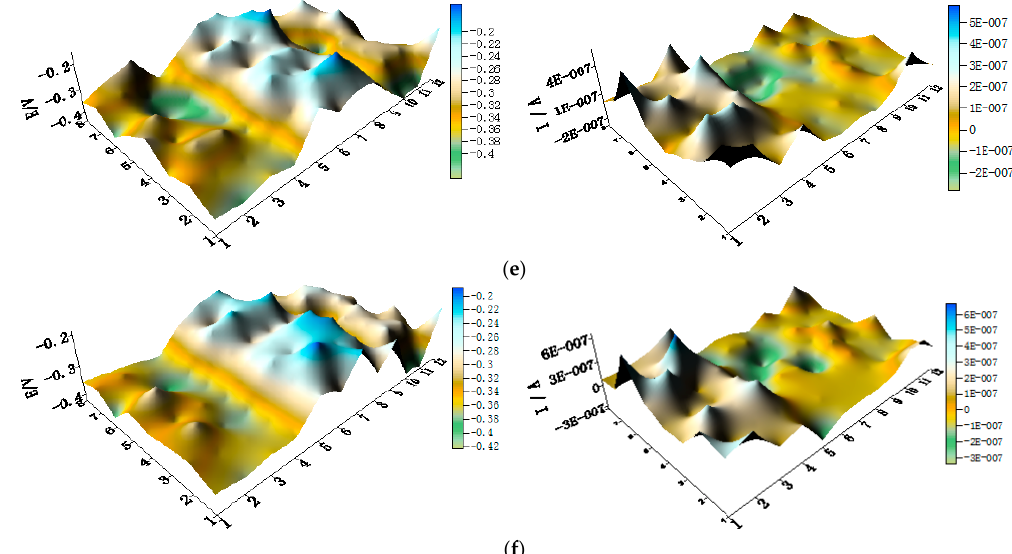
Figure 9. Spatial potential ( left , V/SCE) and corresponding current ( right , I/A) distribution maps of CMEA2 after being short-circuited for 12 h in artificial seawater with different concentrations of chloride ions (wt %): ( a ) 1.5%; ( b ) 1.7%; ( c ) 1.9%; ( d ) 2.1%; ( e ) 2.3%; and ( f ) 2.5%.